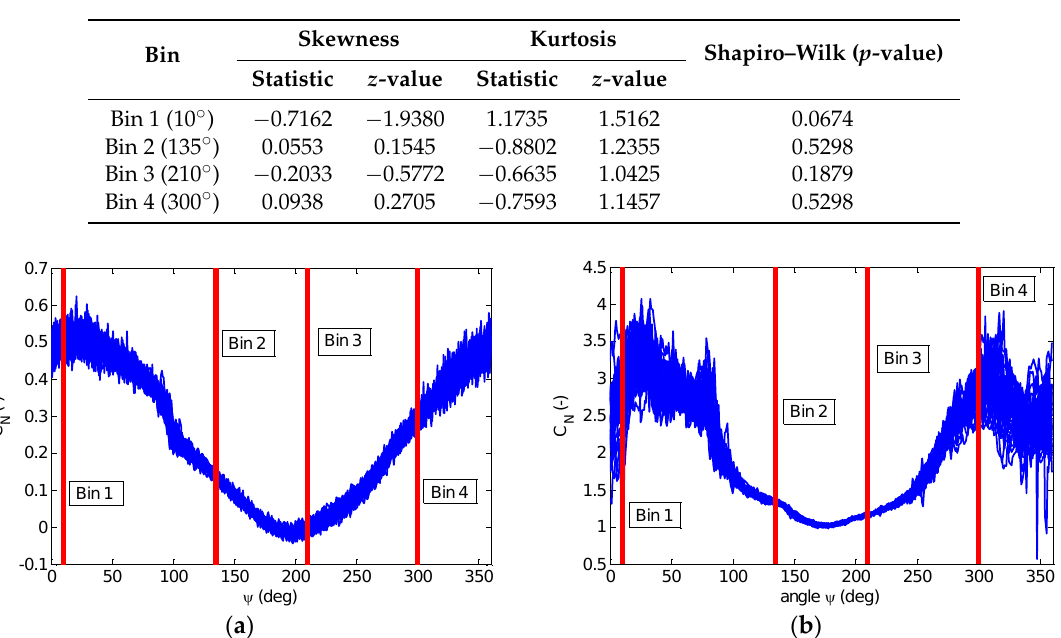
Table 4. A summary of descriptive statics and Shapiro–Wilk’s test for normal force coefficient at U ∞ = 15 m/s, Φ = 30°, and r/R = 0.30.